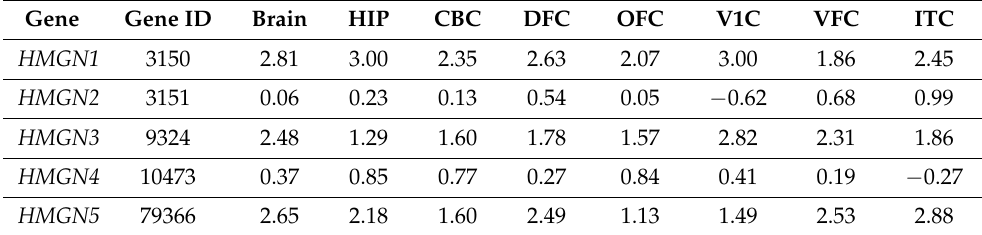
Table 2. Mean Z -ratio values of expression for the five human High-Mobility-Group Nucleosome- Binding (HMGN) genes in several brain structures of individuals with Down Syndrome (DS). Gene Gene ID HIP